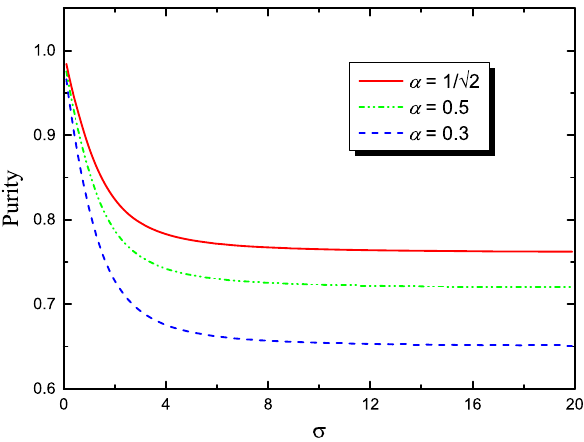
Fig. 2 The purity Tr (ρ 2 ) of the final state of the qubit as a function of the expansion rapidity σ of the cosmic expansion. The qubit energy level difference is (cid:15) = 2, the inner product of the mode functions, defined in Eq. (21), is μ = 0 . 1, the mass of the scalar field particle is m = 0 . 01. The volume of the cosmic expansion is chosen to be ε = ε = 19 , 999 . 5. The initial state of the qubit is α | 0 (cid:7) + β | 1 (cid:7) max